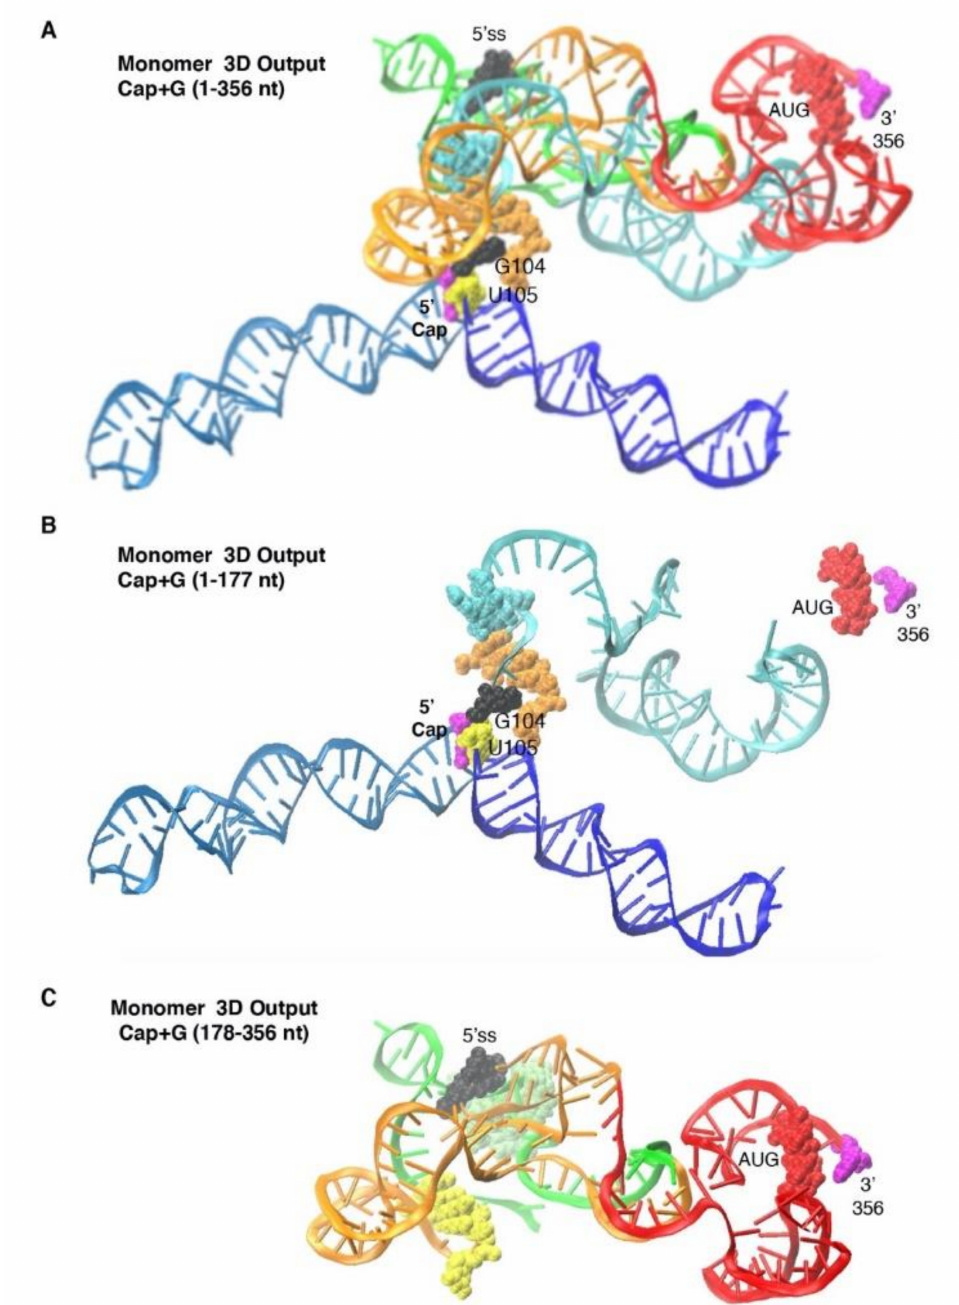
Figure 4. Monomer 3D model identified by SimRNA. ( A ) Most representative model of Monomer-prone 5 (cid:48) -UTR. ( B ) Focus on nt 1–177. ( C ) Focus on nt 178–356. Label colors designate: TAR, light blue; PolyA stem, navy; U5 stem, cyan; PBS, green; DIS stem and three-way junction, orange; 5 (cid:48) -Cap and 3 (cid:48) terminus, magenta; G104, black; U105, yellow; AUG stem, red. 5 (cid:48) -splice site (5 (cid:48) ss), black; DIS, orange ( A , B ), yellow ( C ); gag start codon, red. Notably, only 74% of the Input nt–nt pairings maintained in Monomer Output (Table 1). The lower positive predictive value of Monomer versus Dimer (74% versus 87%, Table 1) suggested U5-DIS helices significantly changed intramolecular folding of 5-UTR relative to